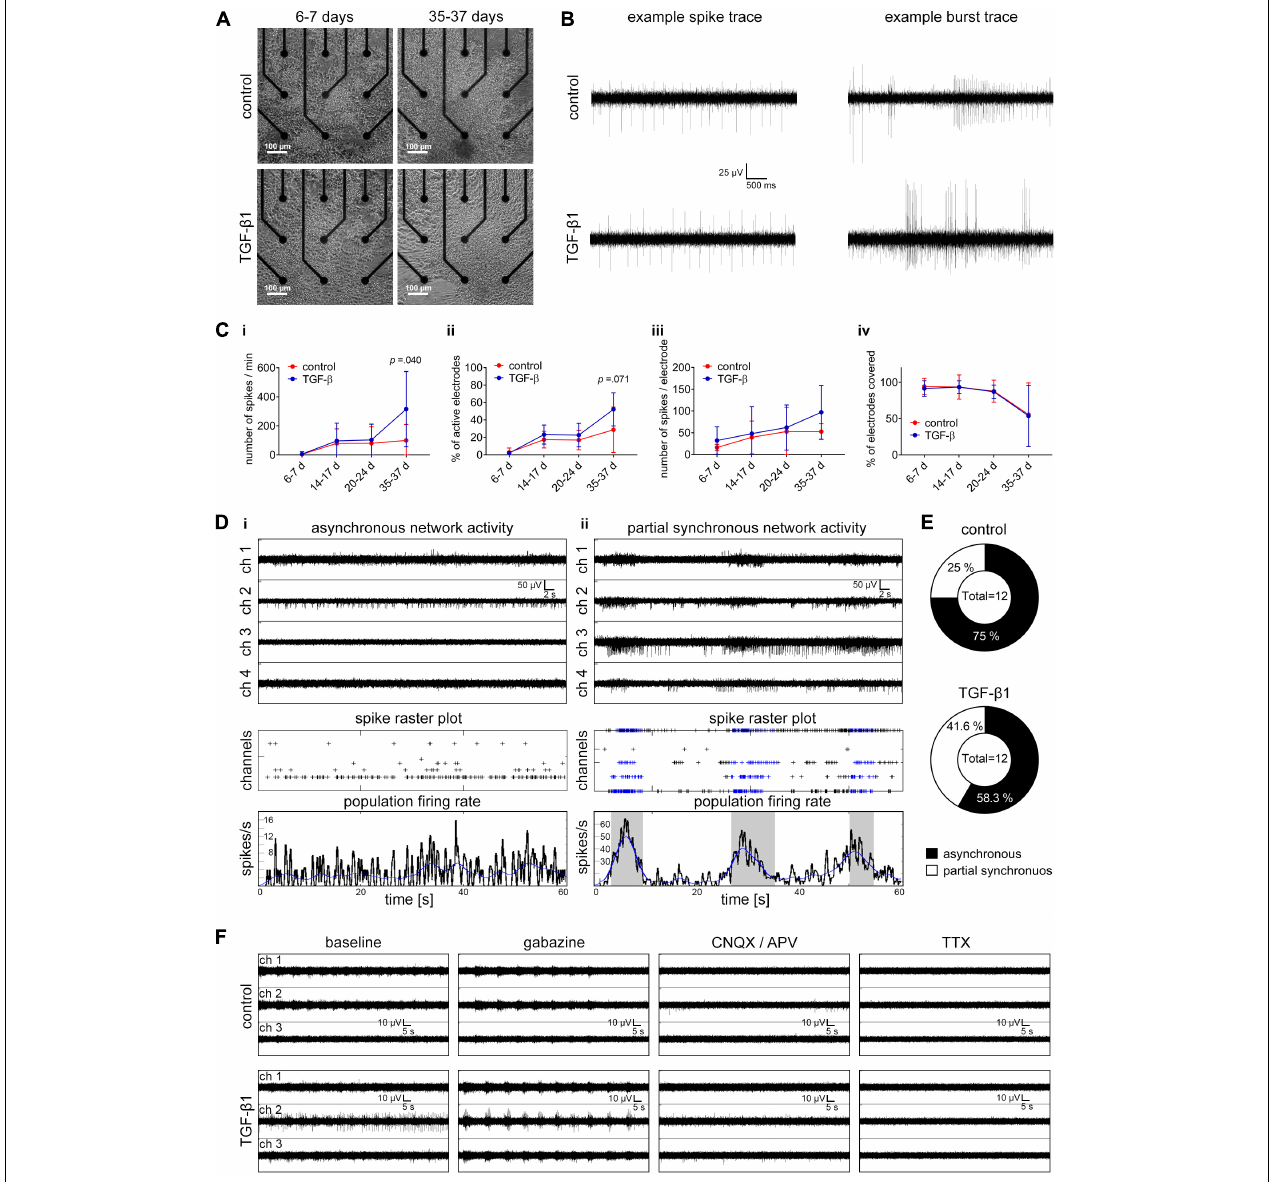
FIGURE 6 | Assessment of TGF- β 1 in functional neuronal circuit formation. (A) Phase-contrast images show the morphology of TGF- β 1 treated and untreated hiPSC-neural cells cultured on a nine-electrode array of a six-well MEA for 1 week and 5 weeks. (B) Example traces of spiking and bursting activity recorded in TGF- β 1 treated and untreated hiPSC-neural cultures. (C) Diagrams illustrate neuronal population activity parameters in TGF- β 1-treated and untreated hiPSC-neural cultures. Data are presented as mean ± SD. Unpaired t -test between the groups was applied to calculate the indicated p -values (hiPSC line C2 and ChiPS4, N = 2–3, n = 6 per condition per line). (D) Representative examples of MEA recordings, spike raster plots (SRP) and population-firing rates illustrate the activity of asynchronously active (i) , and partially synchronously active (ii) neuronal populations. (E) Pie charts illustrate the percentage of hiPSC-neural cultures